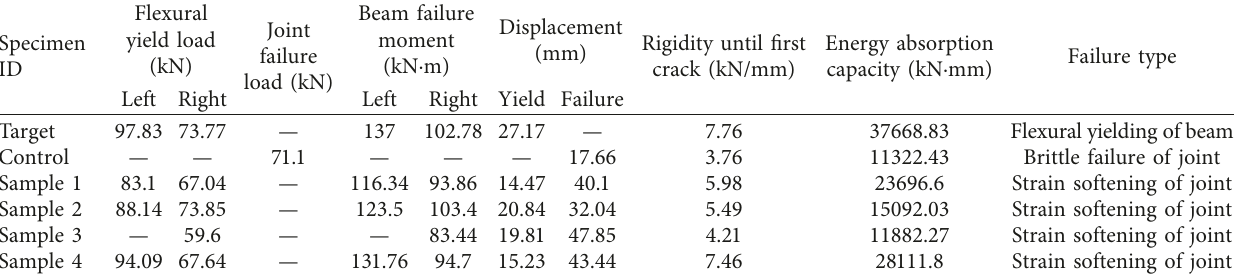
Table 4: Experimental